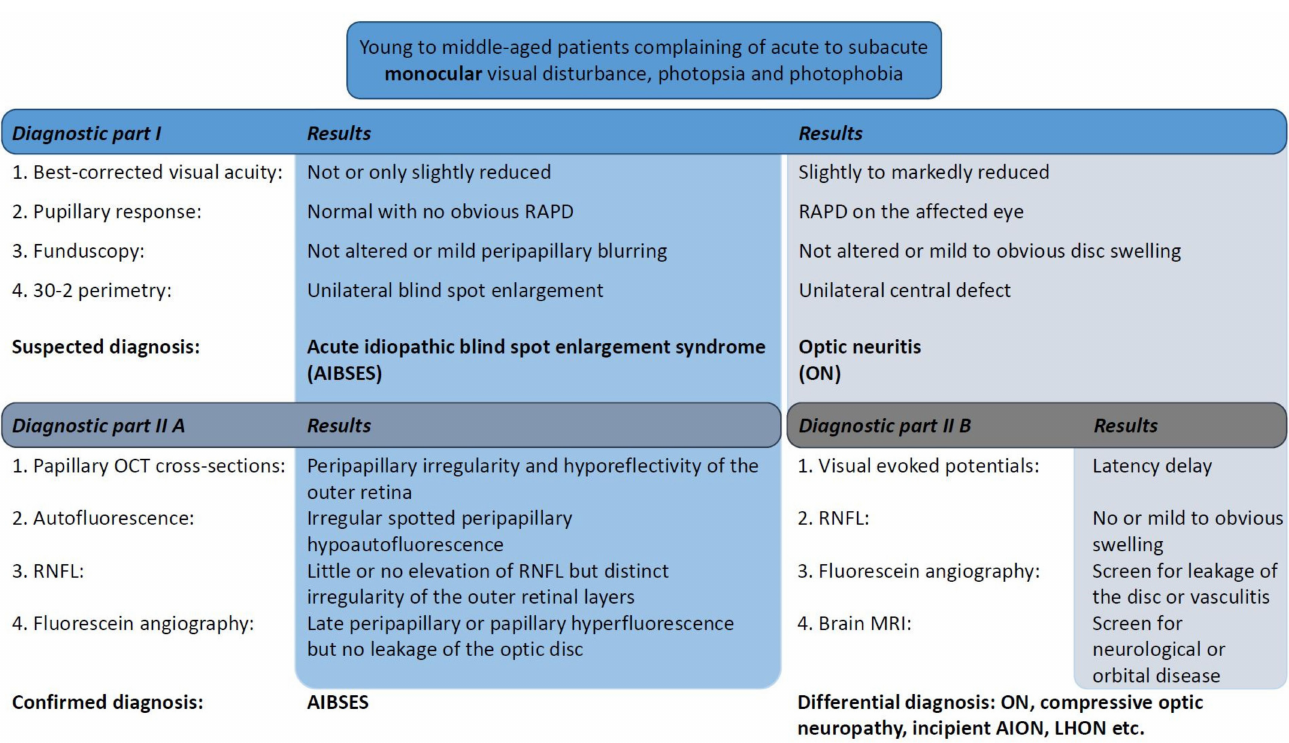
Figure 4. Flowchart of diagnostic workup. After the diagnostic part I ( upper part ), a sound clinical suspicion can be made to differentiate AIBSES from optic nerve diseases. The examinations of diagnostic part IIA ( left ) serve to confirm the diagnosis of AIBSES, especially with the use of papillary OCT cross-sections. Fluorescein angiography is not absolutely necessary. The diagnostic part IIB ( right ) can be used to further differentiate between optic neuritis and other retrobulbar diseases, which more often can affect young to middle-aged patients. RAPD: relative afferent pupillary defect; RNFL: retinal nerve fiber layer; MRI: magnetic resonance imaging; AION: anterior ischemic optic neuropathy; LHON: Leber hereditary optic